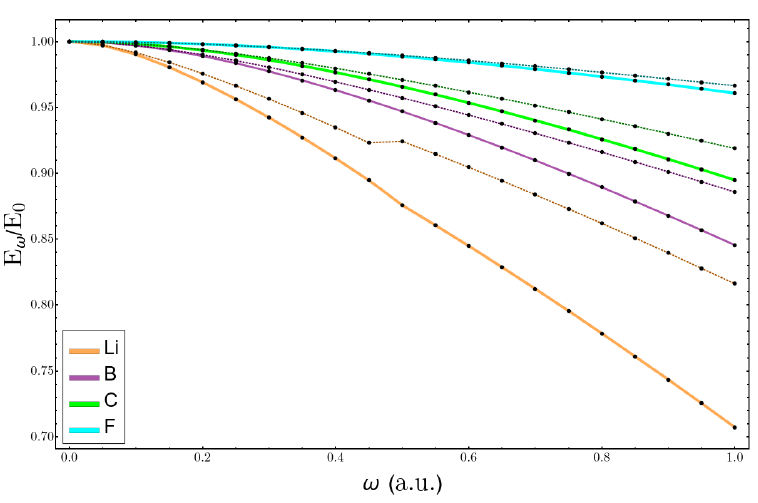
Figure 7. Change in the total energy with confinement relative to the unconfined atom. Solid lines correspond to the calculations solving the Hartree–Fock equations, and broken lines are the perturbation theory